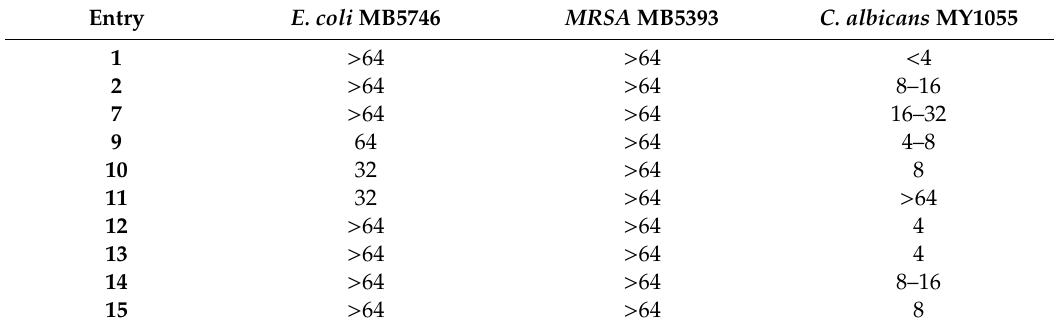
Table 1. Antimicrobial activity of compounds 1, 2 , 7 – 9 , and 10 – 15 . The results are expressed as MIC in µ g /